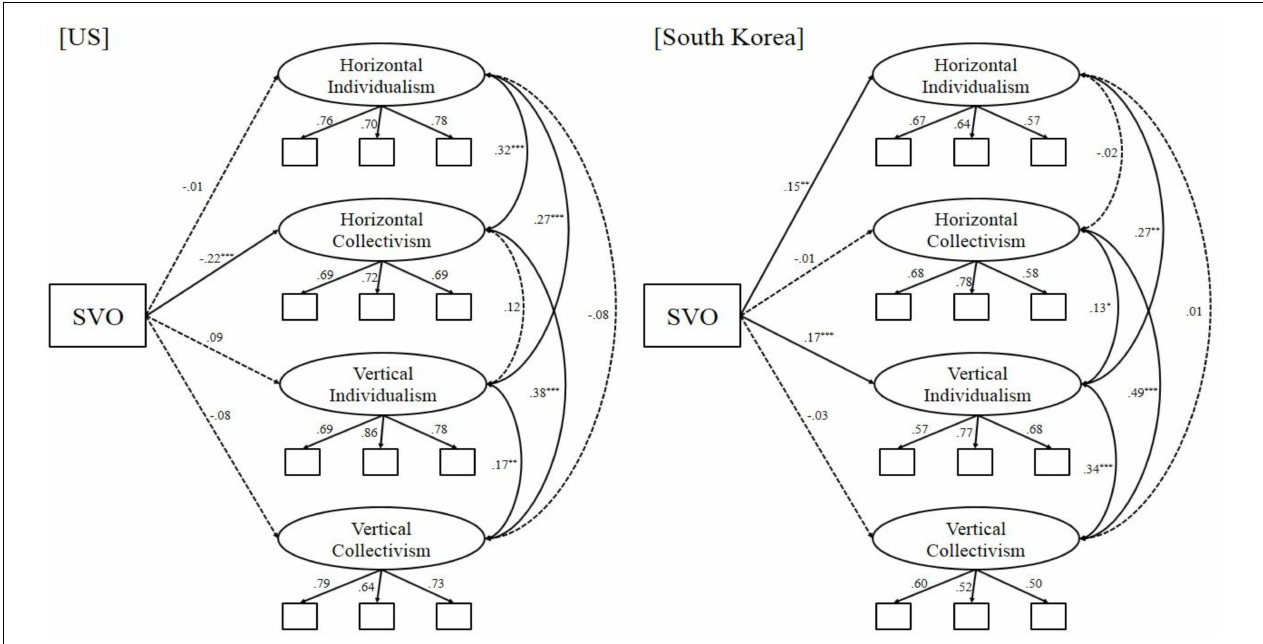
FIGURE 1 | The latent variables model showing coefficients for the predictor of four cultural dimensions (HI, HC, VI, and VC). Dashed lines are non-significant paths. Gender and age are covariates in the model. SVO, social value orientation (coded 1 = prosocial and 2 = proself). ∗∗∗ p < 0.001, ∗∗ p < 0.01, ∗ p <